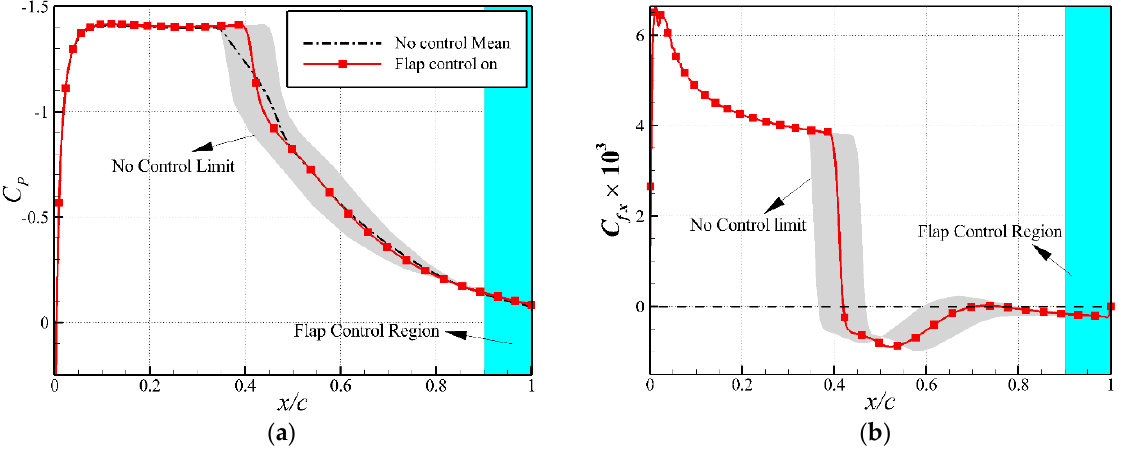
Figure 7. Comparison of aerodynamic force distributions between the flows with and without flap control. ( a ) Pressure coefficient. ( b ) x -component of skin-friction coefficient.